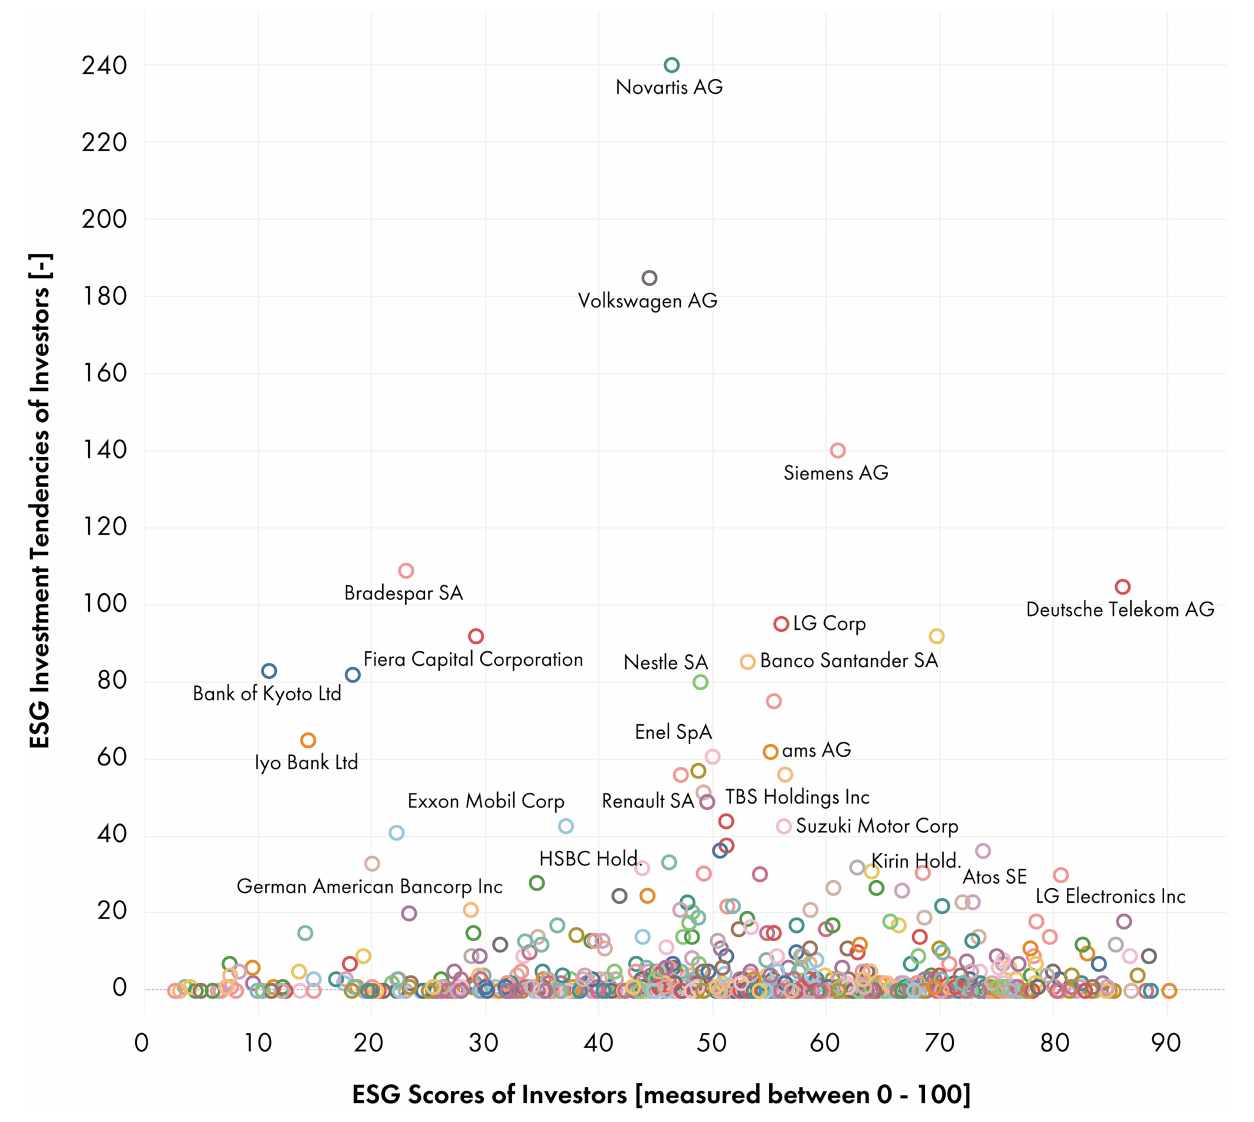
FIGURE 12 | Relation between investors’ ESG scores and ESG